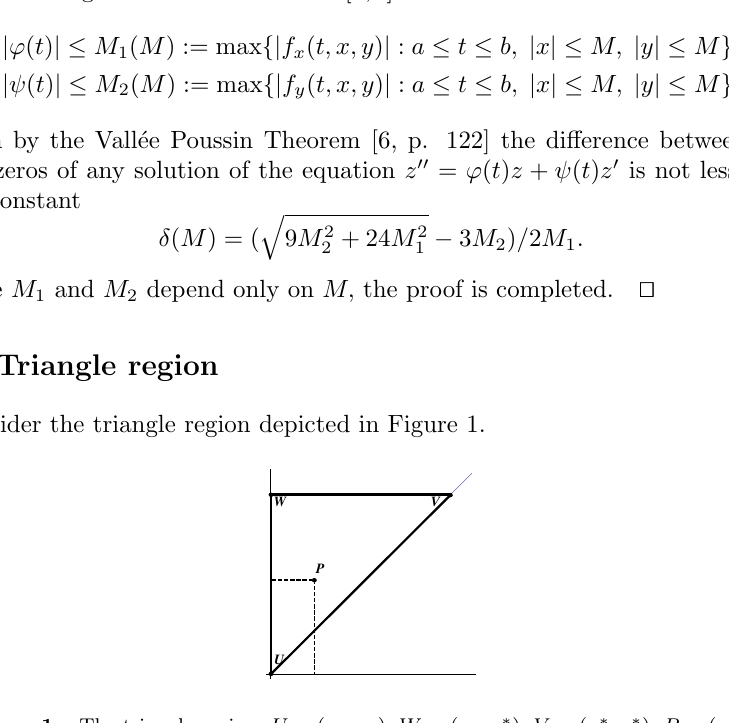
Figure 1. The triangle region: U = ( γ ∗ ,γ ∗ ) , W = ( γ ∗ ,γ ∗ ) , V = ( γ ∗ ,γ ∗ ) , P = ( γ 1 ,γ 2 )